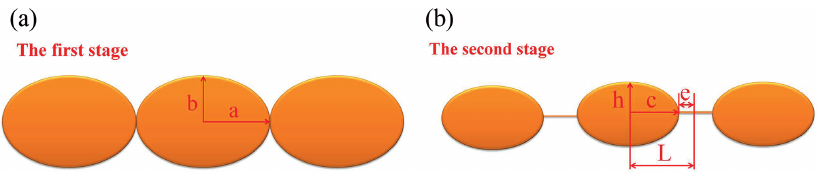
Figure 4: Hill ’ s geometric model: (a) the first stage; (b) the second